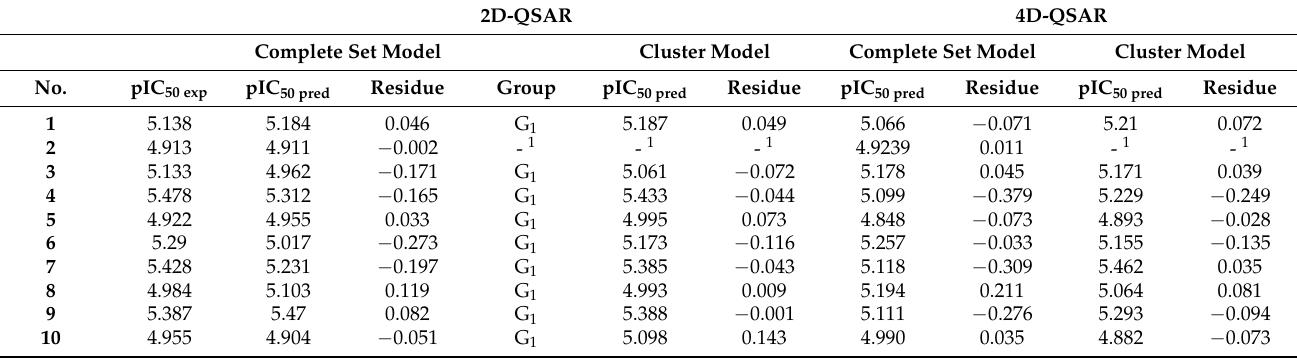
Figure 3. Experimental versus predicted and estimated pIC 50 values for the training and test sets of the G 1 ( left ) and G 2 ( right ) groups. Table 4. Experimental, predicted, and residual values of pIC 50 for the G 1 and G 2 groups.